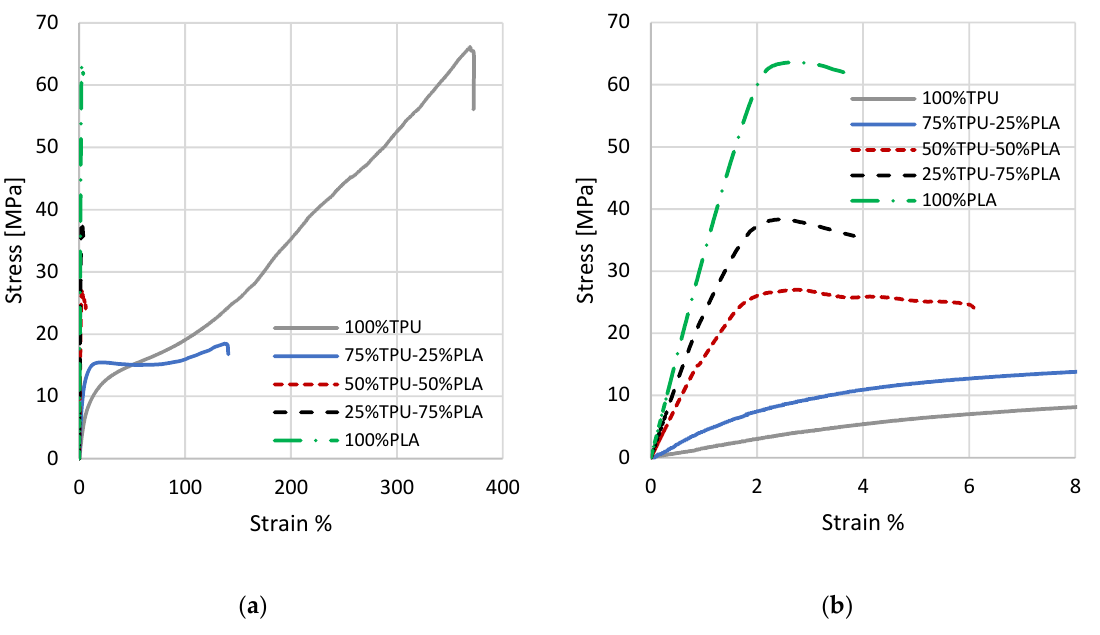
Figure 14. ( a ) Stress – strain curves for the different PLA-TPU mixes. ( b ) Enlargement of the stress – strain curves at low deformation percentages.